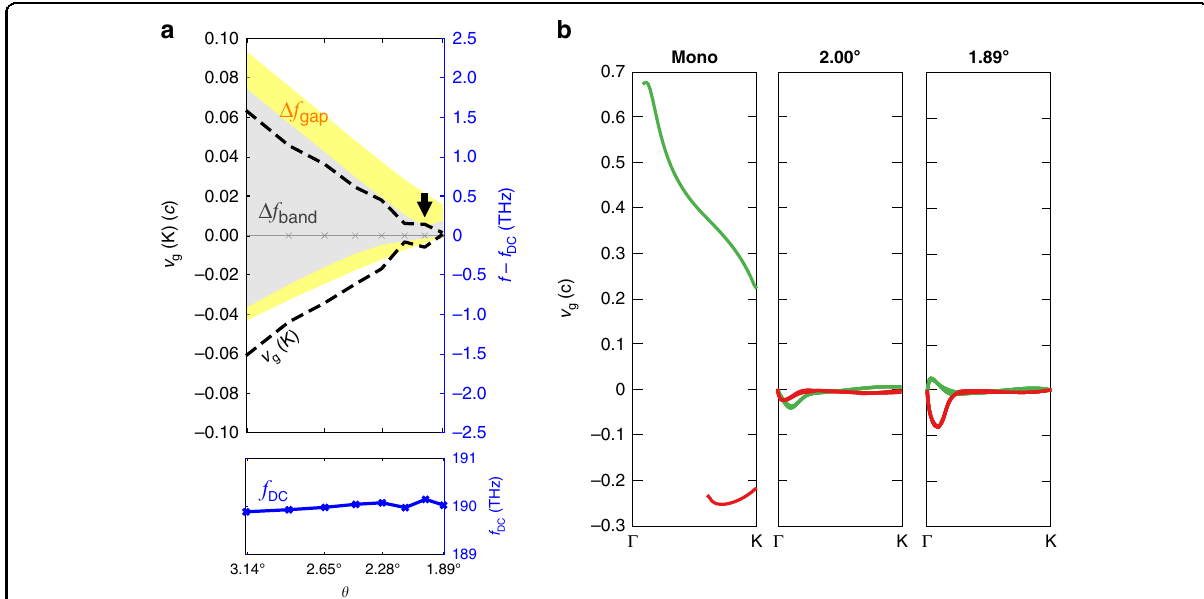
Fig. 4 Decreased group velocity in the twisted bilayer photonic crystals. a Top and bottom bandgap Δ f gap (yellow), bandwidth Δ f band (gray), ð K Þ (black dashed line), and Dirac cone frequency (blue) f v g DC for small commensurate angles. The narrowest bandwidth is pointed by the black arrow. b Group velocity of monolayer con fi guration and the small-angle con fi guration, the lines are cut off by the light cone, the upper part of moiré bands (green) and bottom part of moiré bands (red) has different group velocity from Γ to